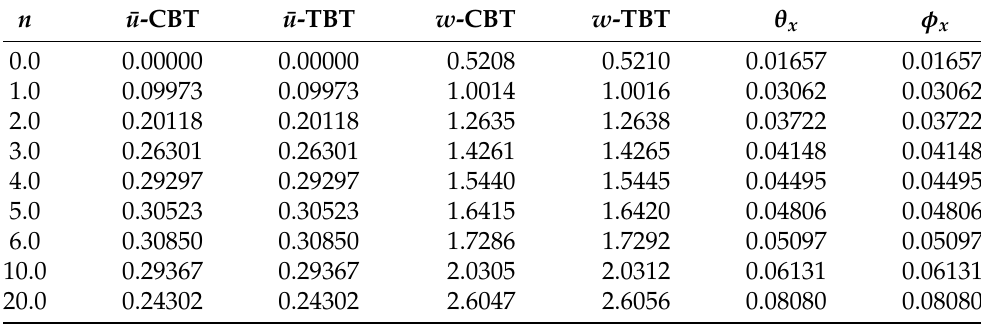
Table 1. Numerical results obtained with the classical (CBT) and the shear deformation (TBT) beam theories for the displacements ¯ u = u ( 0.25 L ) × 10 2 and w ( 0.5 L ) and slopes θ x ( L ) = − ( dw / dx )( L ) and φ x ( L ) of a pinned–pinned FGM beams under a uniformly distributed load (all results are normalized with the